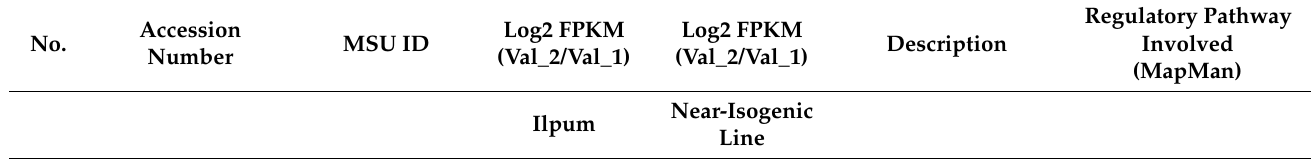
Table 1. Top 20 differentially expressed (DEGs) genes between Ilpum and near-isogenic line.